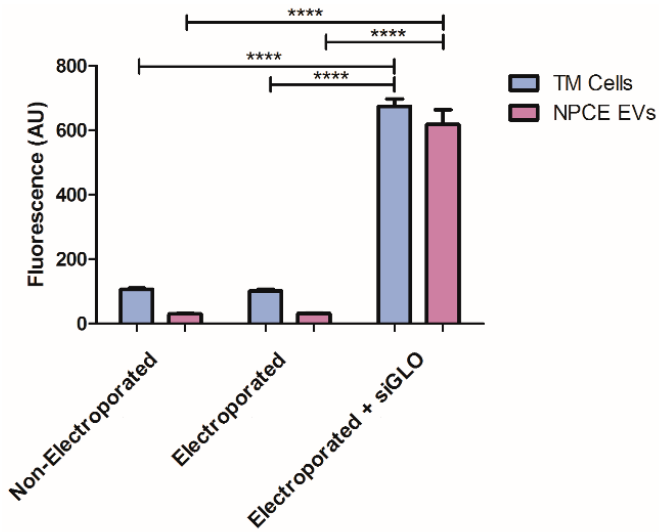
Figure 2. siRNA EVs loading assessment by fluorescence analysis. Testing the encapsulation of fluorescent siRNA in TM cells and NPCE EVs following electroporation. The fluorescent of non-electroporated, electroporated (with no exogenous cargo), and electroporated + siGLO of both TM cells and EVs were evaluated after electroporation. A minimum of three repetition for each group was tested. Two-way ANOVA was used to determine statistical difference, as indicated by asterisks (**** p < 0.0001).